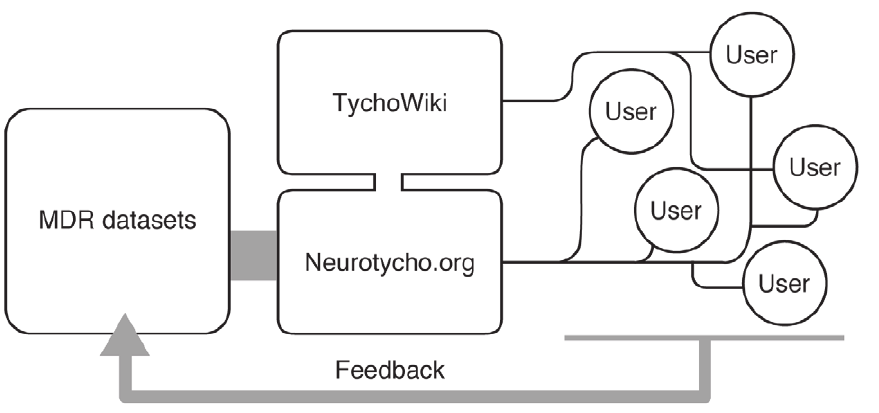
Figure 4. Neurotycho and open research platform. The combination of MDR and Neurotycho.org will provide an open platform for research and education in neuroscience. The interaction between the users and us will improve the quality of the